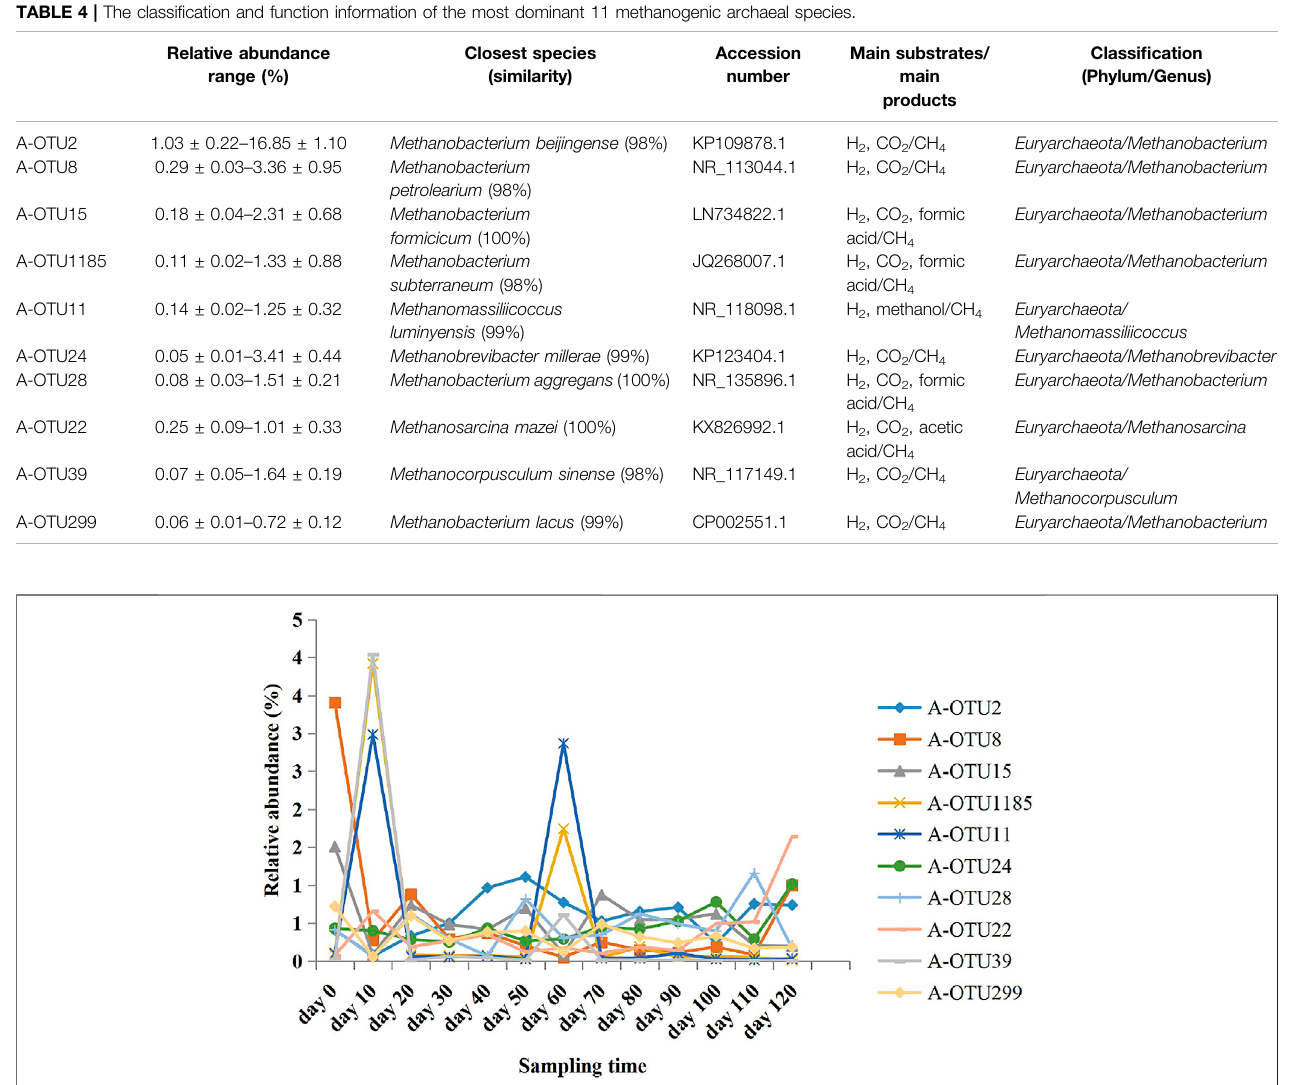
Frontiers in Energy Research |